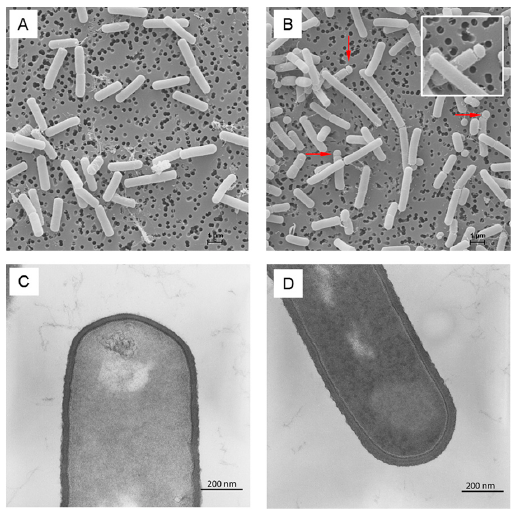
Figure 5. Scanning and transmission electron micrographs of B. subtilis wild type ( A , C ), respectively and clpP mutant ( B , D ), respectively during late stationary phase in minimal medium. Putative minicells and cell chains are marked by arrows ( B ).